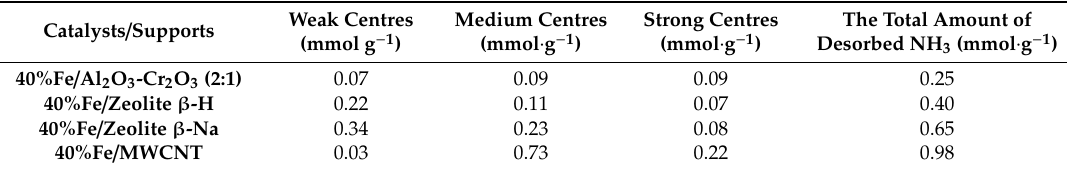
Table 4. The amount of NH 3 adsorbed on the surface of the reduced 40%Fe / MWCNT (multi-walled carbon nanotube), 40%Fe / Zeolite β -H, 40%Fe / Zeolite β -Na and 40%Fe / Al 2 O 3 -Cr 2 O 3 (2:1) catalysts (reduction for 1 h in a mixture of 5%H 2 -95%Ar at 500 ◦ C) calculated from the temperature programmed desorption (TPD-NH 3 ) measurements.